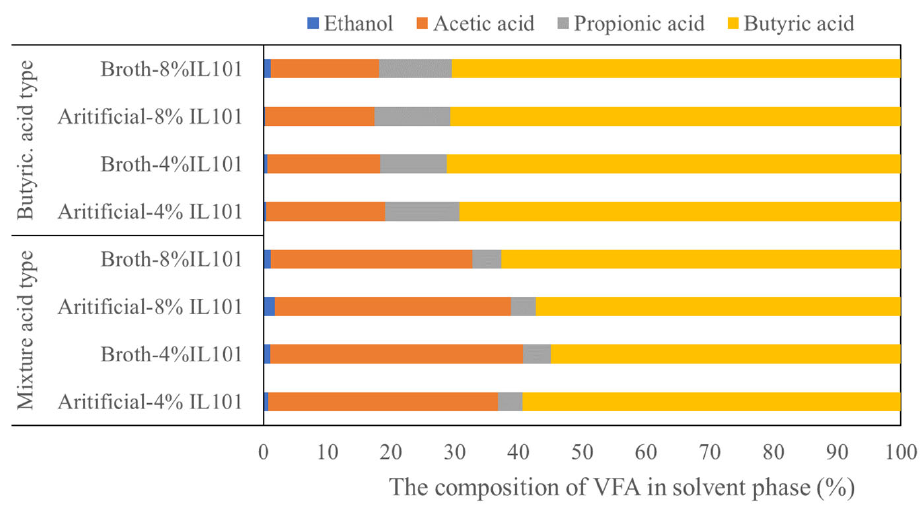
Figure 5. The composition of VFA in solvent phase after extraction.